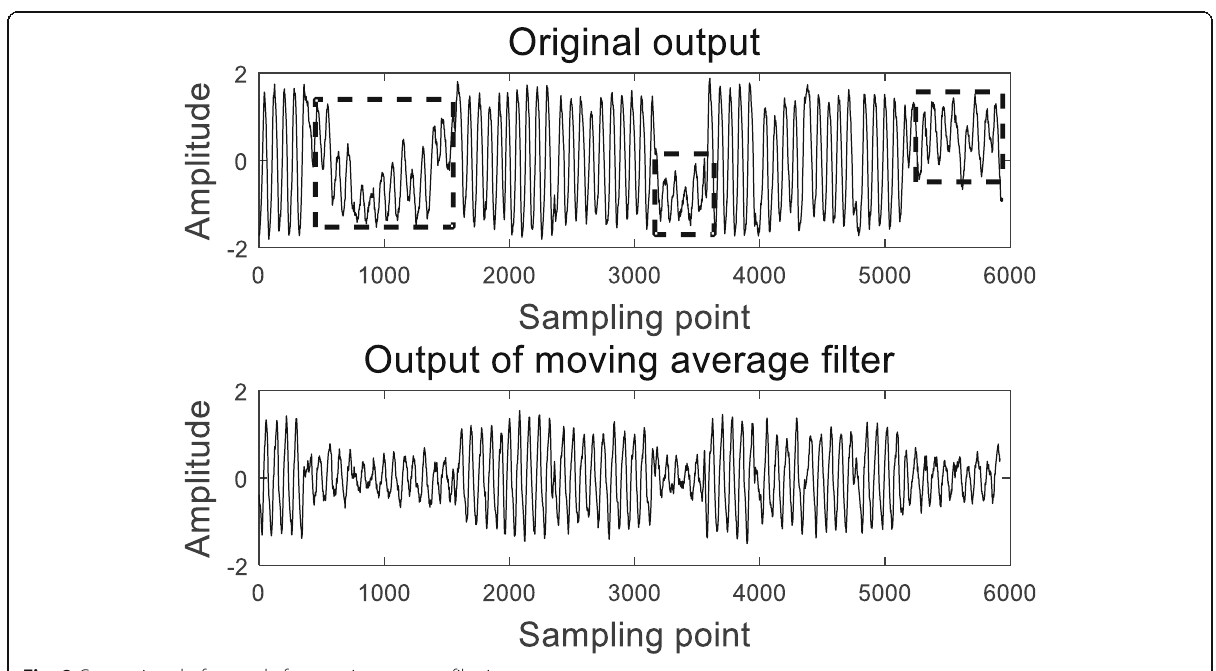
Fig. 8 Comparison before and after moving average